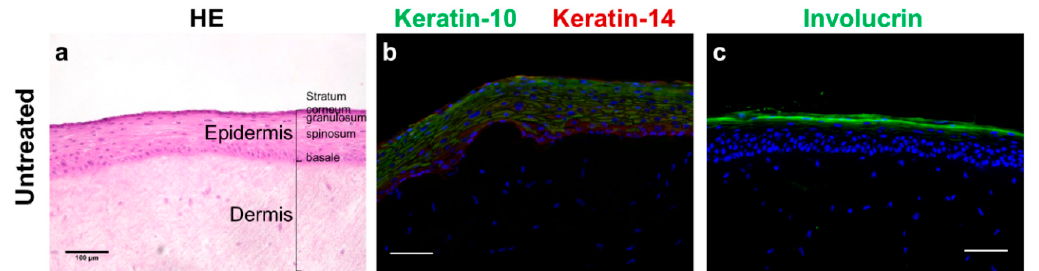
Figure 1. Morphology and protein expression in reconstructed human skin. ( a ) Hematoxylin-eosin staining showing all layers of human skin. ( b ) Immunolocalization of keratin-10 (green) in suprabasal epidermal layers and keratin-14 (red) in all epidermal layers. ( c ) Immunolocalization of involucrin (green), indicating terminal keratinocyte differentiation. Images are representative of three batches; nuclei in blue (DAPI); scale bars = 100 μ m.